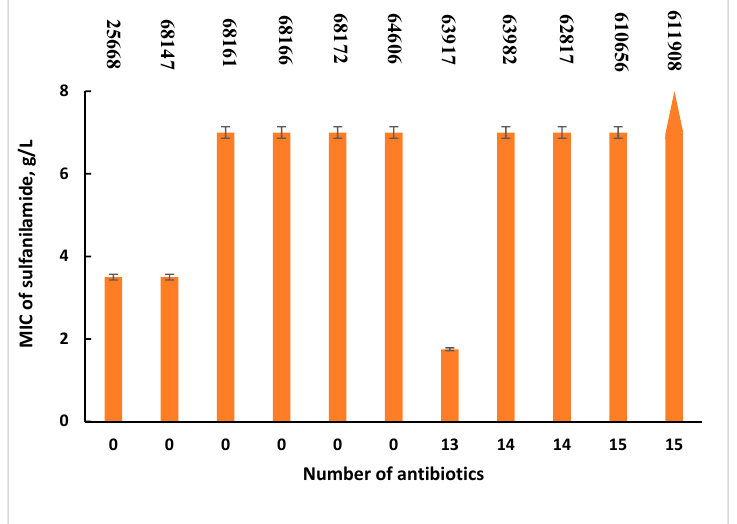
Figure 3. MIC values of sulfanilamide for P. aeruginosa strains resistant up to 15 antibiotics. Error bars represent standard errors.